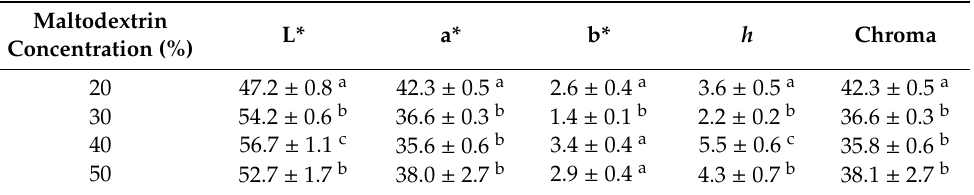
Table 2. Color parameter of Andean blueberry juice freeze-dried powders obtained with di ff erent concentrations of maltodextrin.